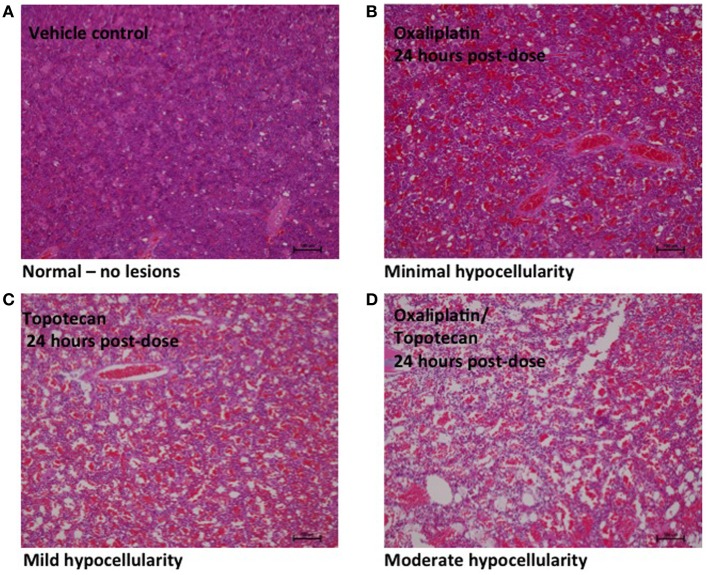
Representative images of bone marrow hypocellularity in femur from male rats 24 h after a single 30 min IV infusion dose of oxaliplatin, topotecan or combination of oxaliplatin followed by topotecan. Hematoxylin and eosin stained tissue sections; 10X objective; bars = 100 μm. (A) Male rat exposed to vehicle control. (B) Minimal hypocellularity in male rat exposed to oxaliplatin. (C) Mild hypocellularity in male rat exposed to topotecan. (D) Moderate hypocellularity in male rat exposed to oxaliplatin followed by topotecan. Bone marrow hypocellularity was graded based on the estimated percentage of cell loss with minimal hypocellularity = 10–20% cell loss, mild hypocellularity = 30–40% cell loss, moderate hypocellularity = 50–60% cell loss, and marked hypocellularity = greater than 60% cell loss.